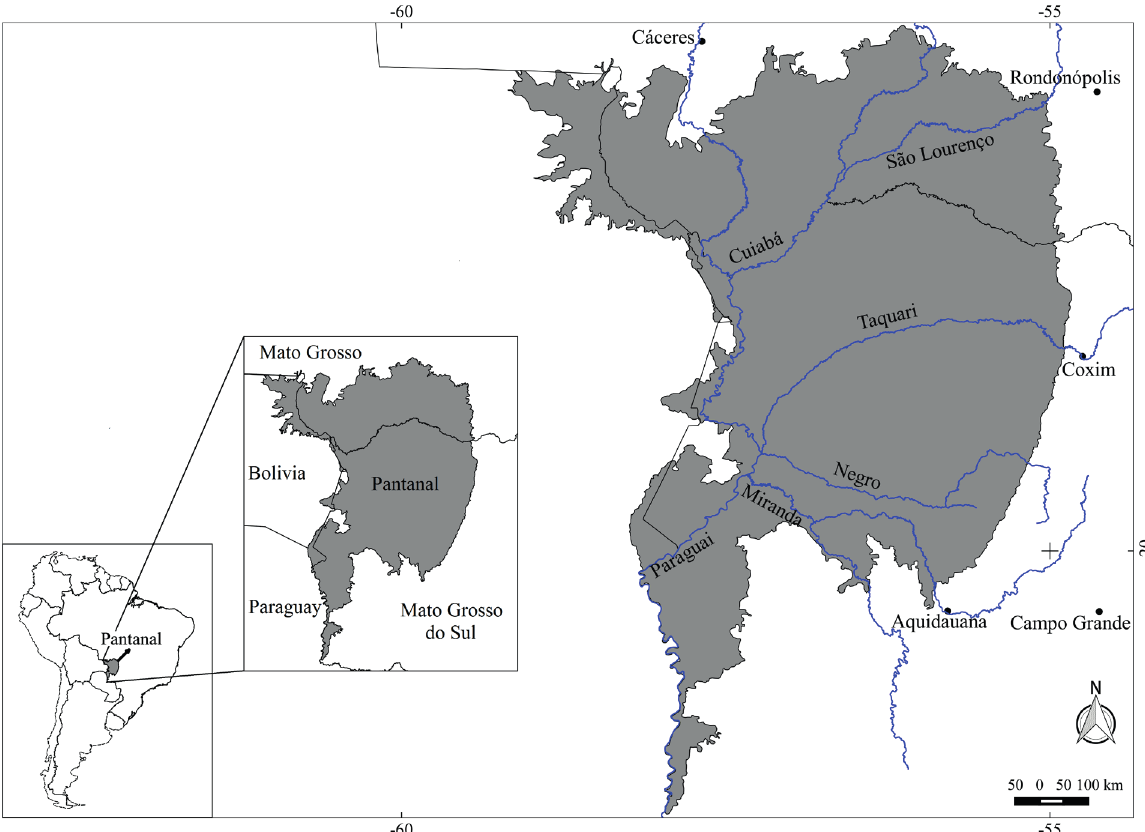
Figure 2 - the location of Pantanal. the Pantanal boundary presented in grey is proposed by Mioto et al. (2012), who consider that Pantanal extends to Bolivia and